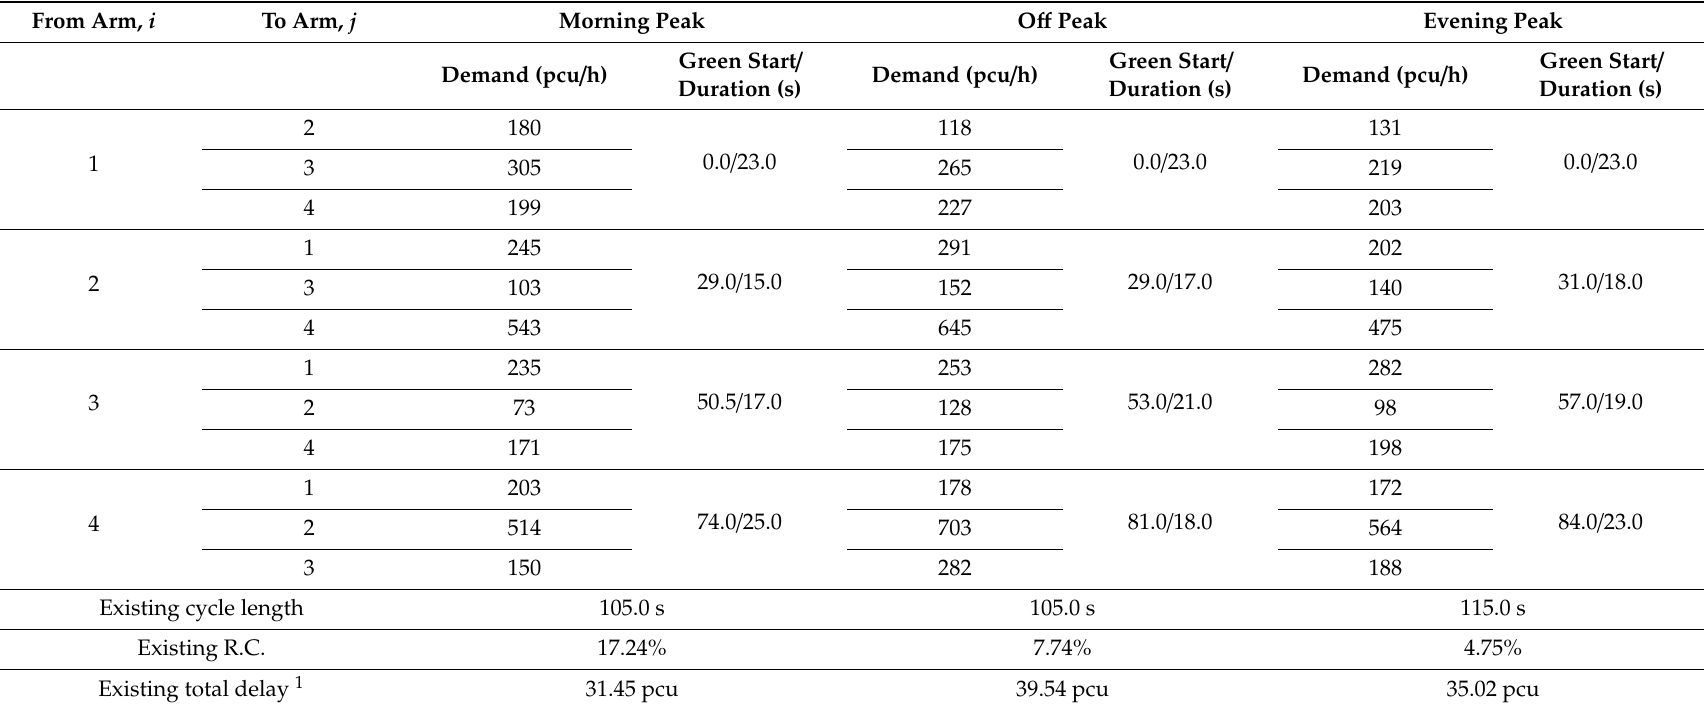
Table 1. Tra ffi c demand pattern, existing signal settings and junction